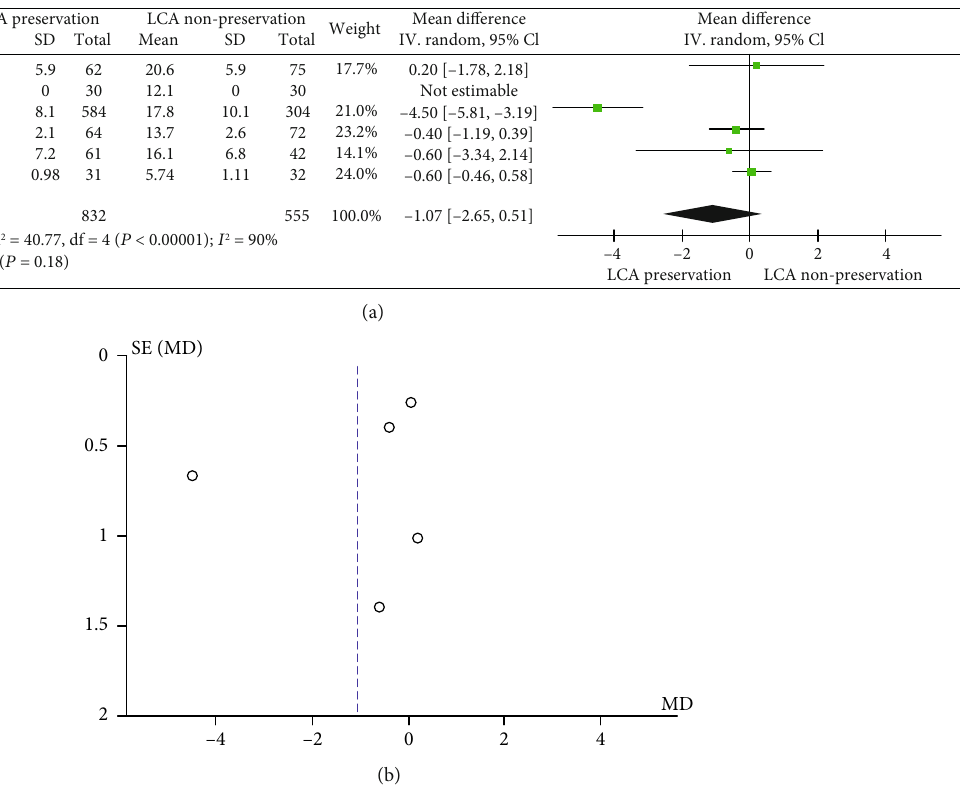
Figure 5: (a) Forest plot of number of dissected lymph nodes; (b) funnel plot of number of dissected lymph